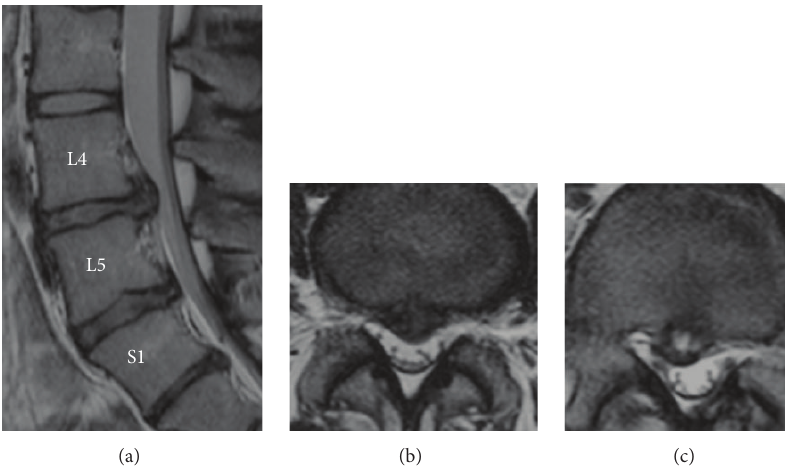
Figure 2: MRI showed posterior lumbar disc herniation connecting the nucleus pulposus tissue at L4/5 at the age of 18 years ((a) and (b)). The lumbar disc herniation at L5/S1 was absorbed, although the posterior endplate lesion still remained at L5/S1 ((a) and